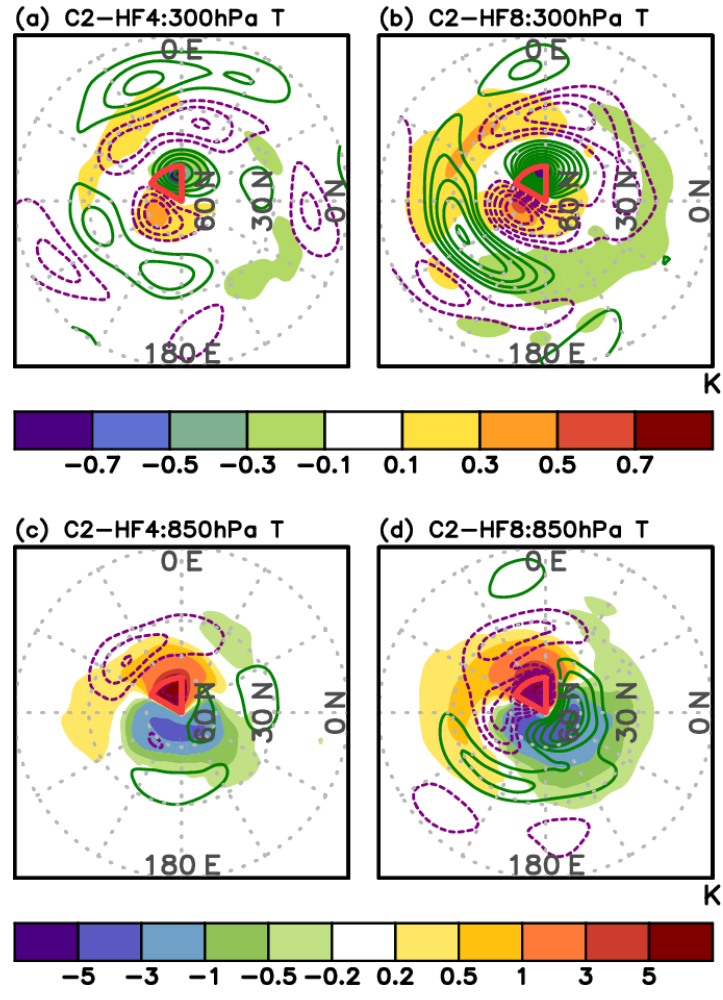
Figure 5 . Time-mean zonal deviation: ( a , b ) 300 hPa temperature (shaded, unit: K) and stream function (contours, 4 × 10 5 m 2 /s); ( c , d ) 850 hPa temperature (shaded, unit: K) and stream function (contours, 4 × 10 5 m 2 /s). Purple contours are negative, and green contours are positive. The red triangle represents the area of prescribing Q-flux.